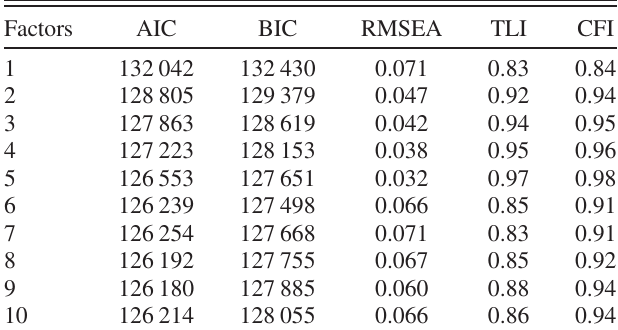
TABLE II. MIRT fit statistics.